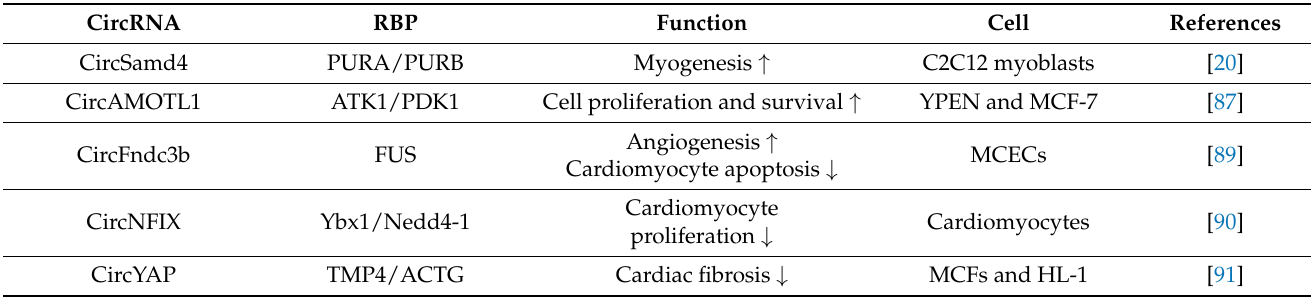
Table 1. Summary of circRNAs and their protein chaperones in muscle development and